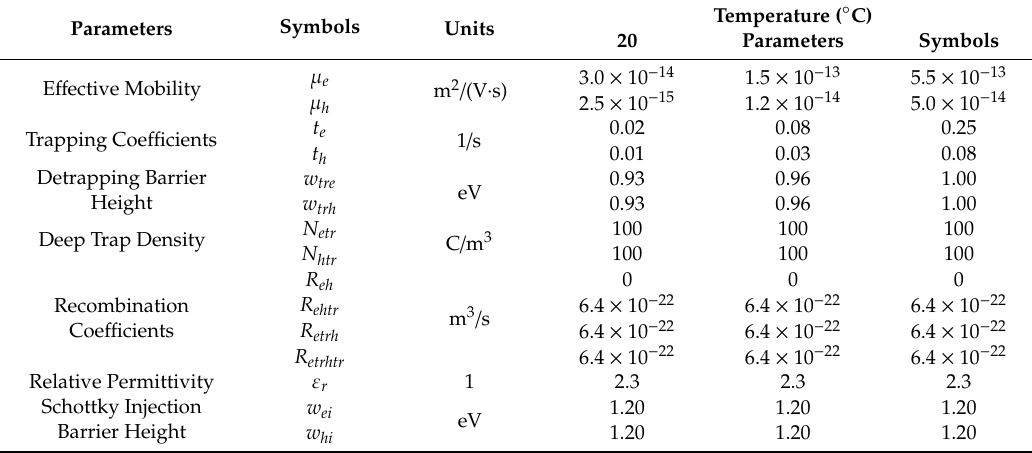
Table 1. Parameters used in BCT model [14–20].